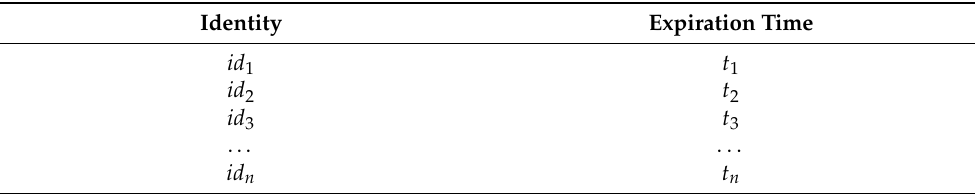
Table 2. Authenticated consumer